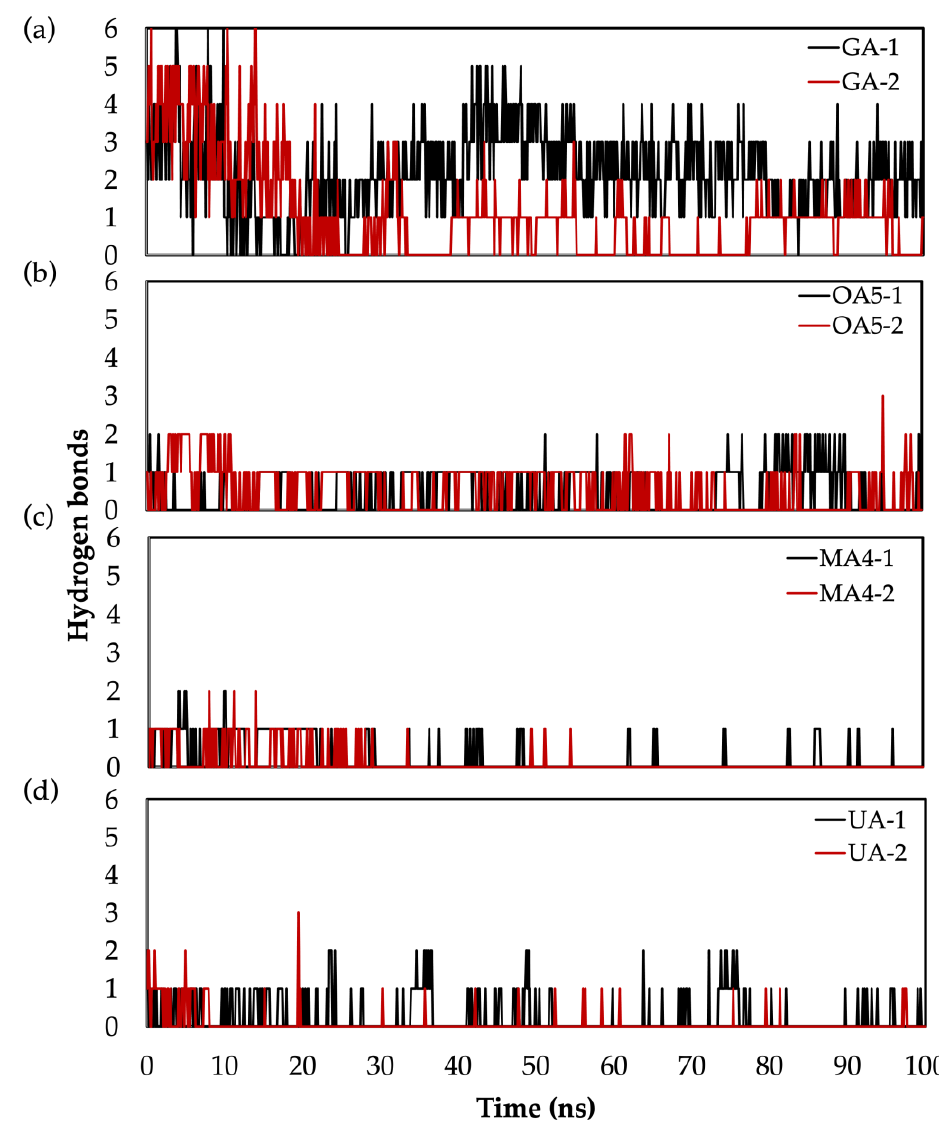
Figure 7. Number of H-bonds during MD for: ( a ) GA, ( b ) OA5 , ( c ) MA4 and ( d ) UA2 . Black representation corresponds to replica 1, and red to replica 2.